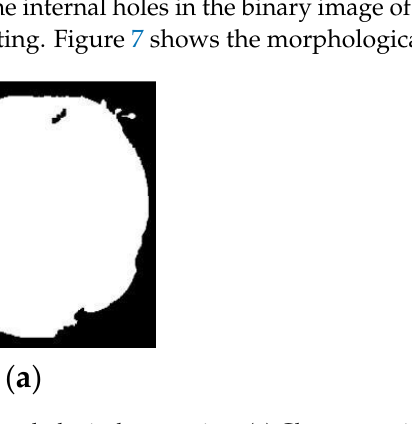
Figure 7. Morphological processing . ( a ) Close operation, ( b ) Open operation.